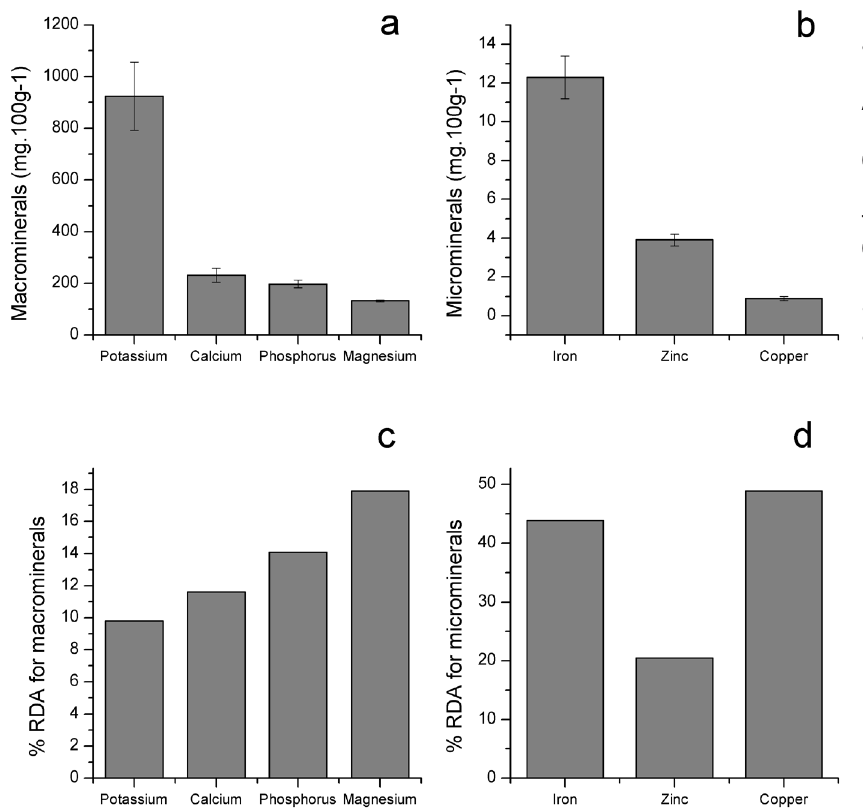
Figure 1. Macromineral (a) and microminerals (b) of umbu ( Spondias tuberosa Arr. Cam.) processing by- product flour and covering (%) of the Recommended Dietary Allowances (RDA) for an adult in a serving (50 g) (c, d). The error bars indicate the standard deviation from the mean of three